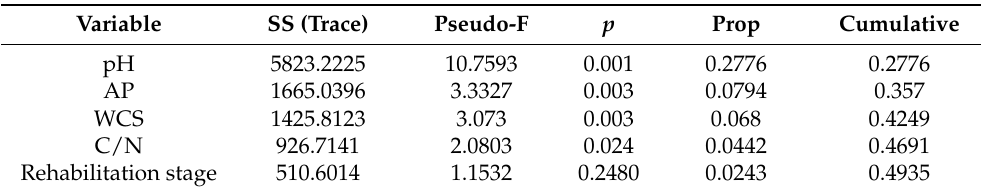
Table 3. Distance-based multivariate analysis for a linear model (DISTLM) results of bacterial community data against four predictor variables selected for inclusion in the model for all sites (9999 permutations).